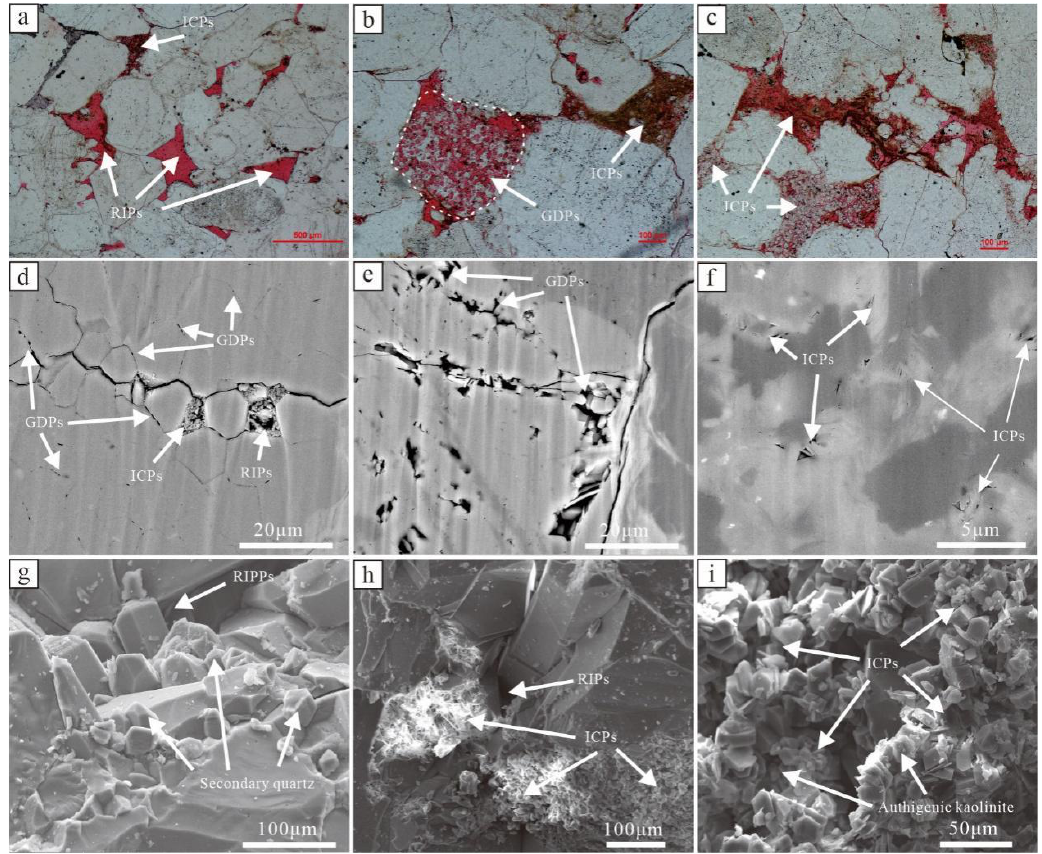
Figure 6. Microreservoir space of nano–micro pores in tight sandstone reservoirs. ( a ) RIPs and ICPs under high-resolution microscope; ( b ) GDPs under high-resolution microscope; ( c ) ICPs under high-resolution microscope; ( d ) RIPs, GDPs and ICPs under FESEM; ( e ) GDPs under FESEM; ( f ) ICPs under FESEM; ( g ) RIPs and secondary quartz under SEM; ( h ) RIPs and ICPs under SEM; ( i ) ICPs and authigenic kaolinte under SEM.